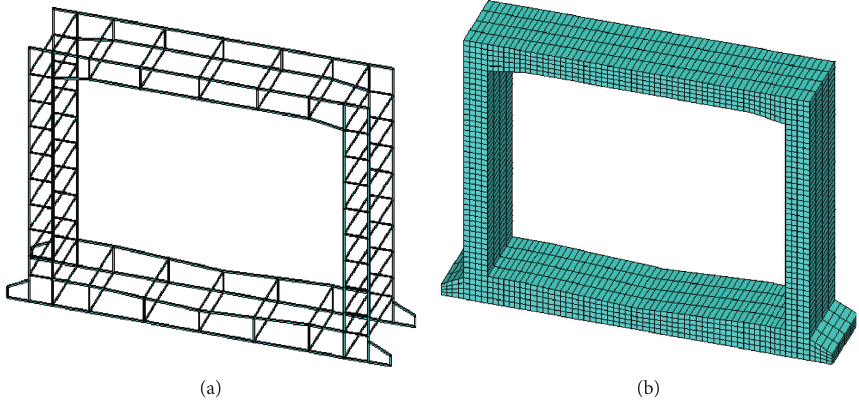
Figure 9: Finite element model of integral type BC. (a) Reinforcement model. (b) Concrete model.